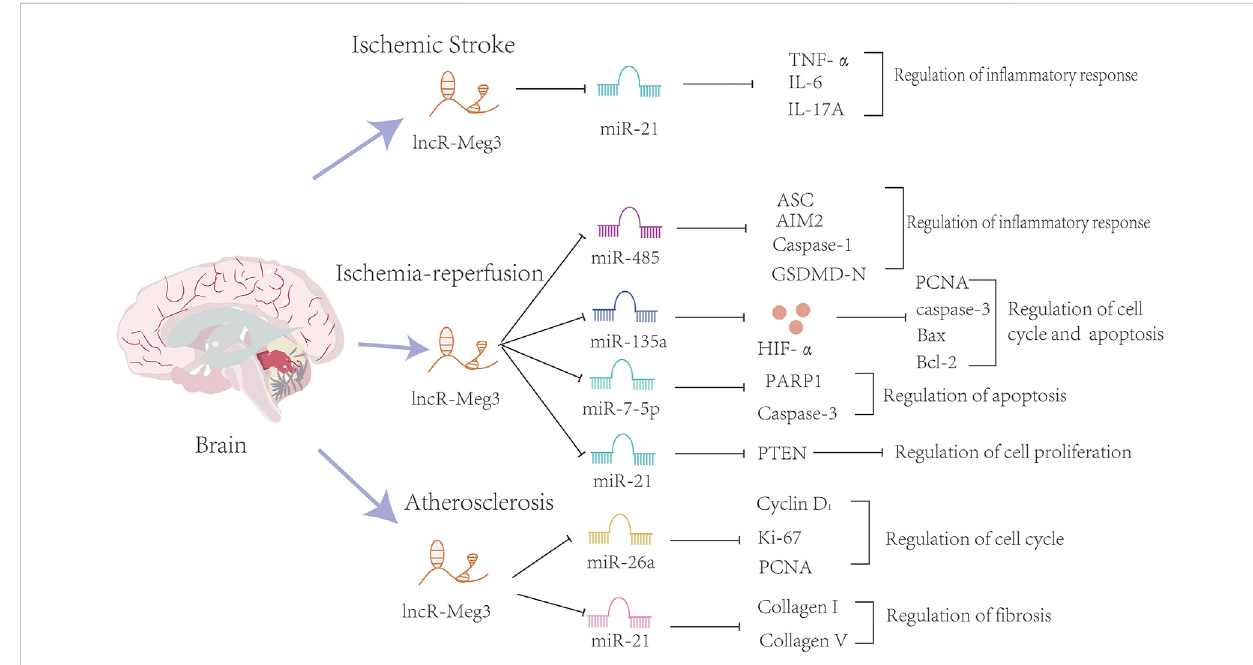
FIGURE 4 The mechanisms of the involvement of lncR-Meg3 in cerebrovascular diseases. Several miRNAs such as miR-21, miR-482, miR-135a, miR-7-5p, miR21, miR-26a and miR-21 play a role in these diseases. These miRNAs inhibit the expression of downstream target genes. Serving as a sponge, lncR- Meg3 degrades miRNAs and in fl uences the progression of in fl ammatory response, cell cycle and